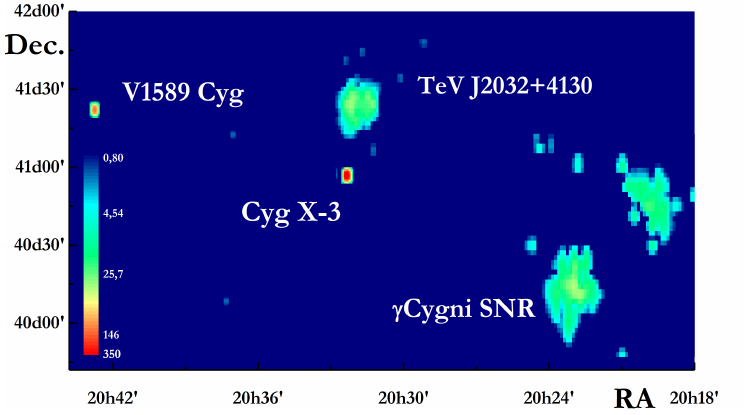
Figure 2. Emission map of the Cyg X-3 centering region viewed by